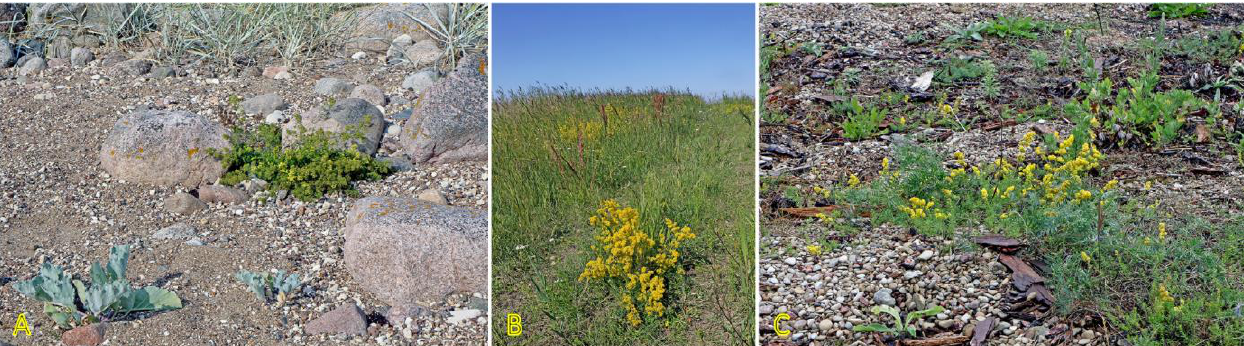
Figure 11. Galium verum plants together with Crambe maritima and Leymus arenarius on a gravel beach on the island of Kihnu, Estonia ( A ), on a coastal sandy meadow in Kuiviži, Latvia ( B ), on a gravel beach on the island of Saaremaa, Estonia ( C ).